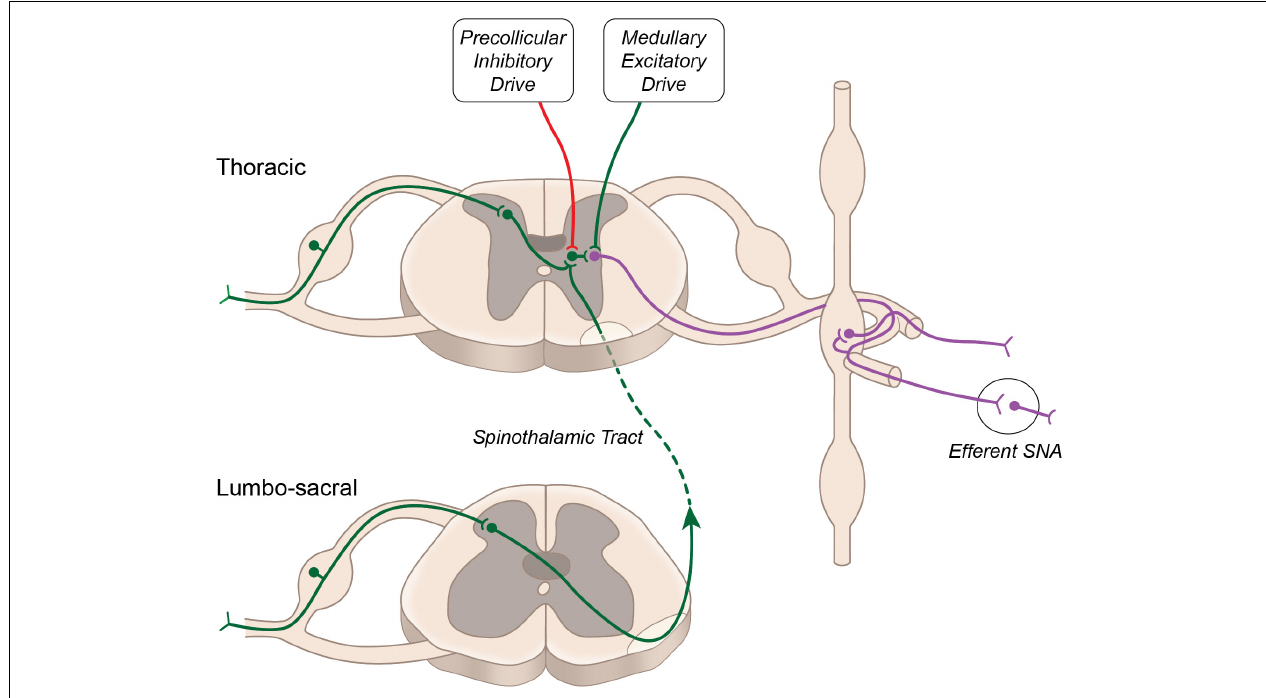
FIGURE 1 | Neural circuitry regulating sympathetic nerve activity. Major excitatory drive to sympathetic preganglionic neurons arises from the rostral ventrolateral medulla. Additional excitatory input from propriospinal projecting neurons is buffered by descending inhibitory drive arising above the level of the superior